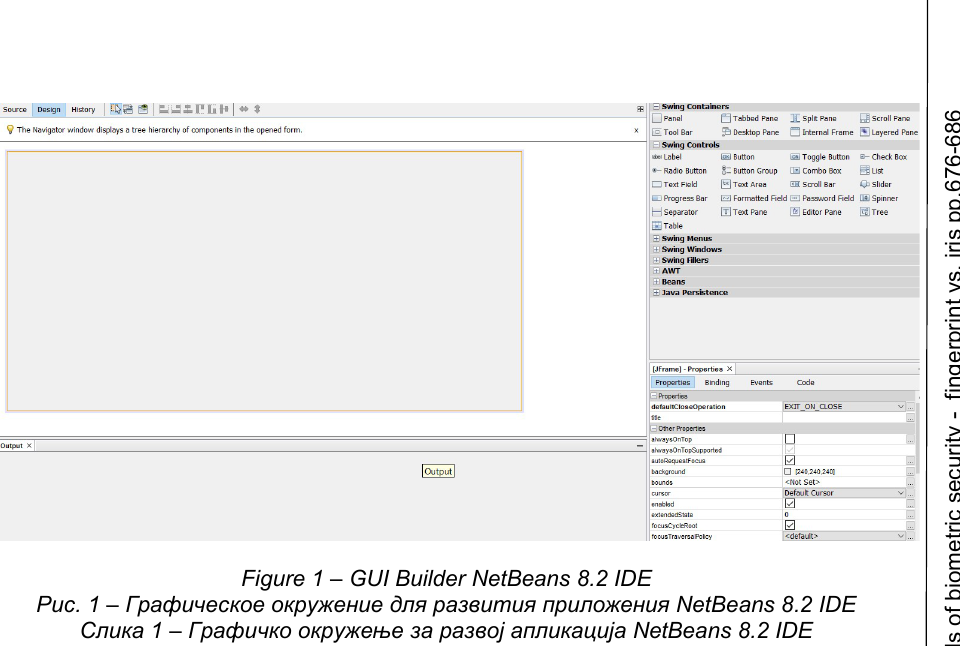
Figure 1 – GUI Builder NetBeans 8.2